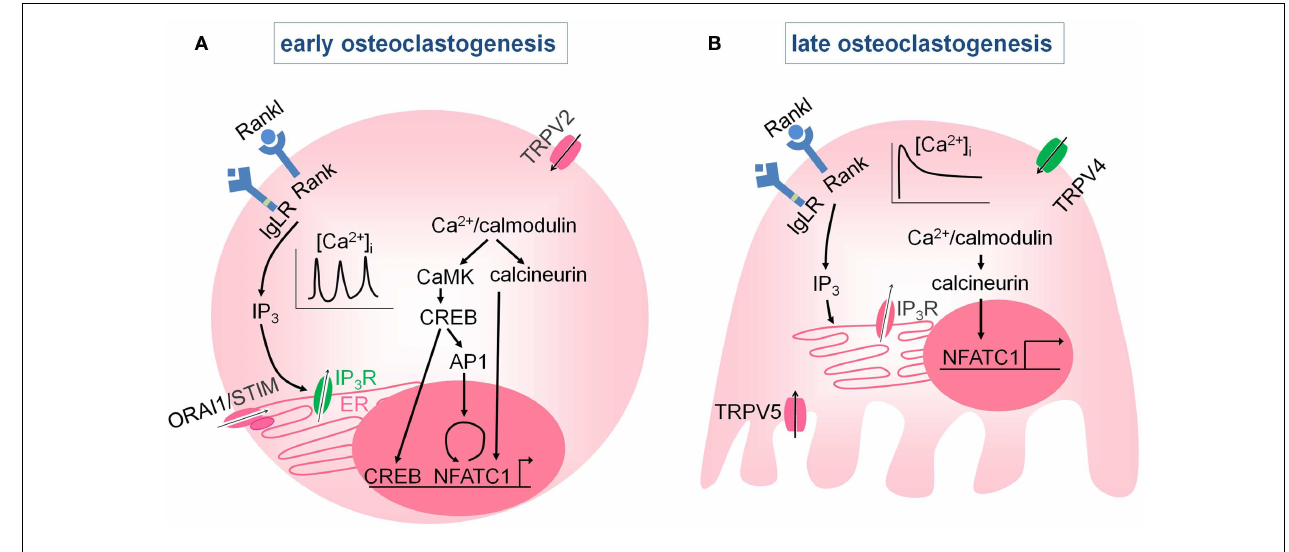
FIGURE 3 | Intracellular Ca 2 + signaling in osteoclasts. (A) Early during osteoclast differentiation, activation of the RANK, and IgLR receptors induces intracellular Ca 2 + oscillations by intracellular Ca 2 + release via the IP 3 R, and possibly via Ca 2 + influx through store-operated Ca 2 + channels or TRP (TRPV2) channels.The Ca 2 + oscillations activate Ca 2 + / calmodulin-dependent kinases (CaMK, calcineurin) which